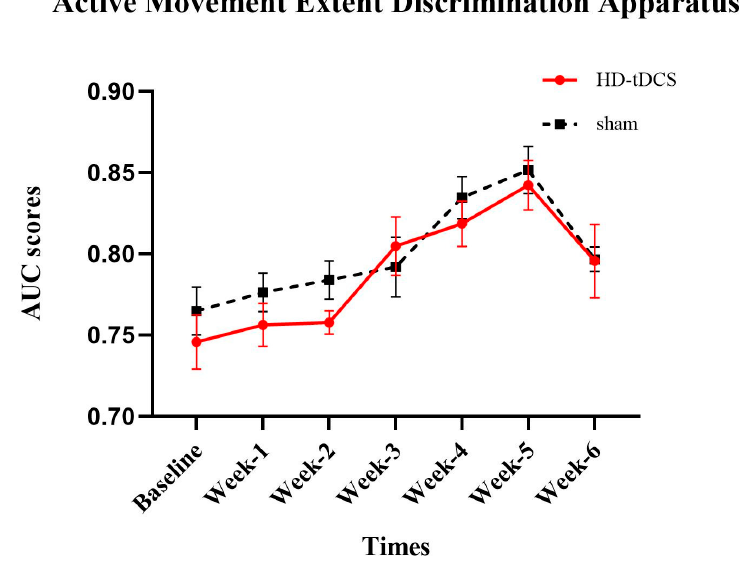
Figure 3. Active movement extent discrimination apparatus (AMEDA) performance (mean ± SE). Higher area under the curve (AUC) score reflects better proprioception function. Both interventions were associated with improvements compared to the baseline ( p < 0.05).